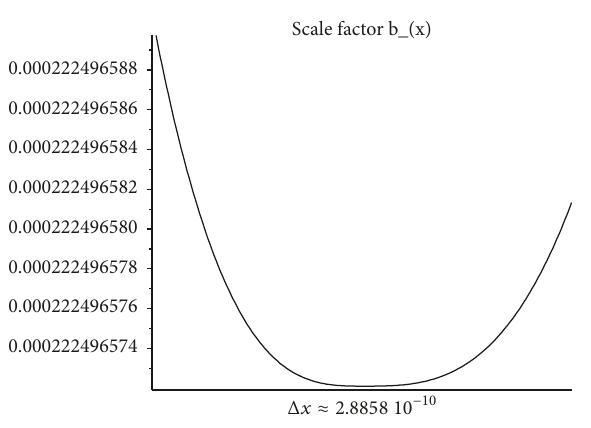
̇𝑏(𝑥)/𝑏(𝑥) : 𝐻 𝑚 (1) = 1 is the current = −0.84 . 2